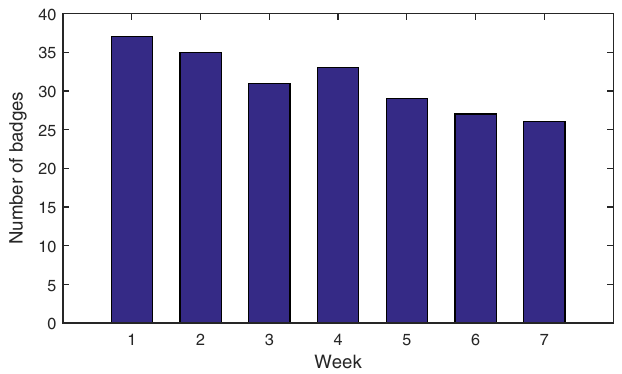
FIG. 4. Number of badges awarded each week during the course. Each user could only receive one badge per